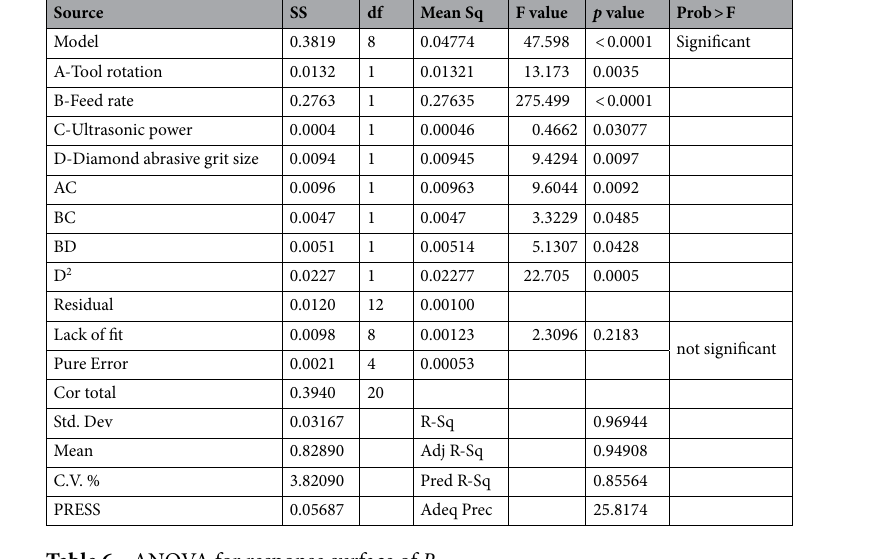
Figure 7 represents the standard residual probability curve which shows that residues are inside ± 3 limits and that they are fixed by the MR and Ra straight lines. Figure 8 demonstrates that the estimated model values are true to MR and Ra experimental values. This reveals that ANOVA table findings are reliable. Equation (2) and (3) represents the regression model for MR and R a respectively.